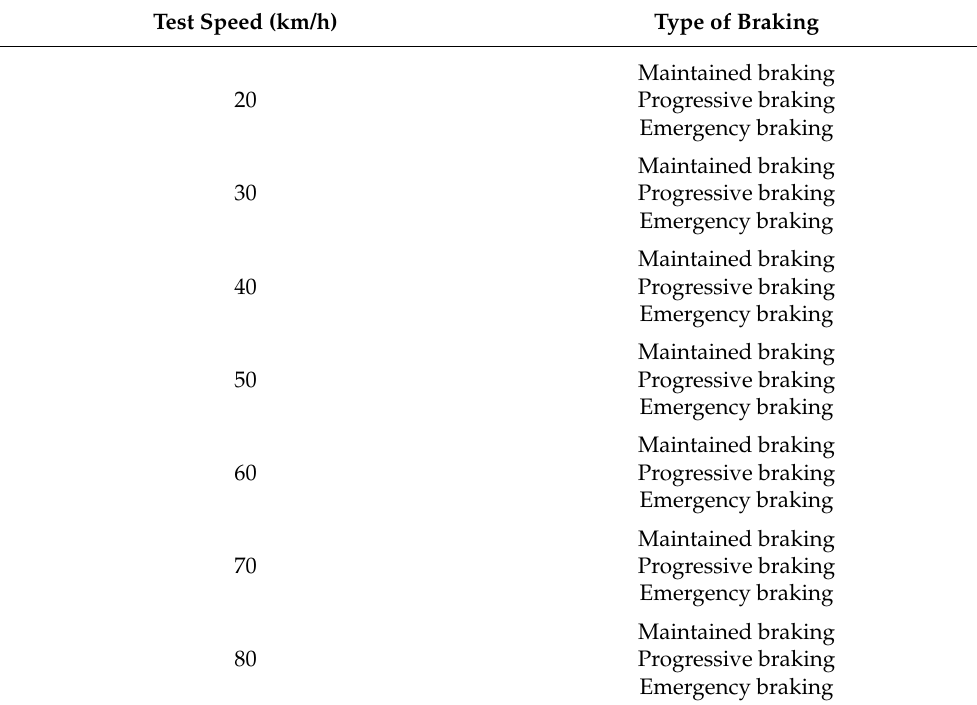
Table 1. Tests carried out by different